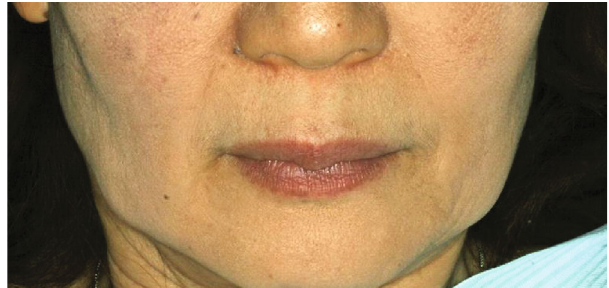
Figure 1: Extraoral photograph showing symmetrical facial features.